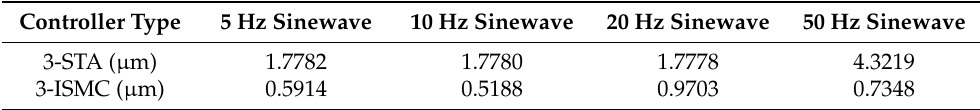
Table 2. Comparison Results of Trajectory Tracking with